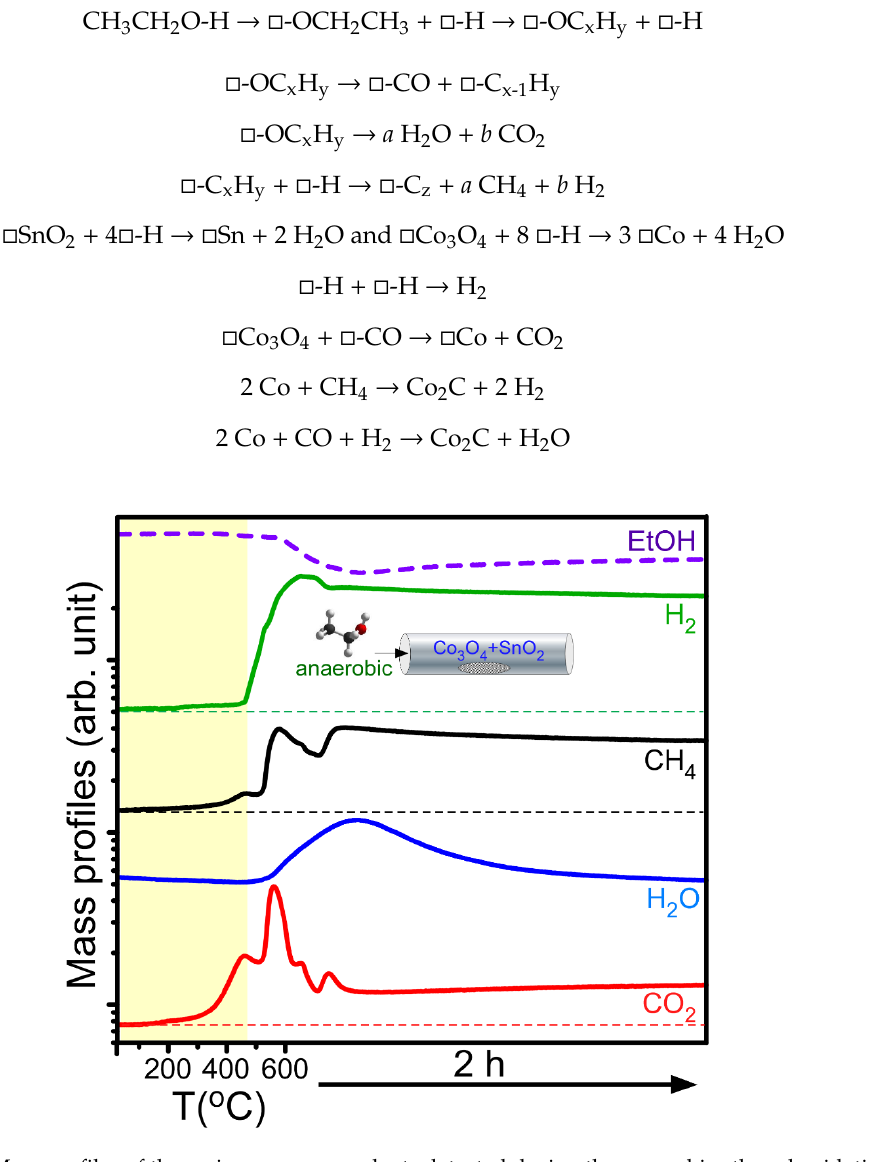
Figure 4. Mass profiles of the major gaseous products detected during the anaerobic ethanol oxidation reactions over the Co 3 O 4 NPs mixed with 5 mol% SnO 2 NPs.